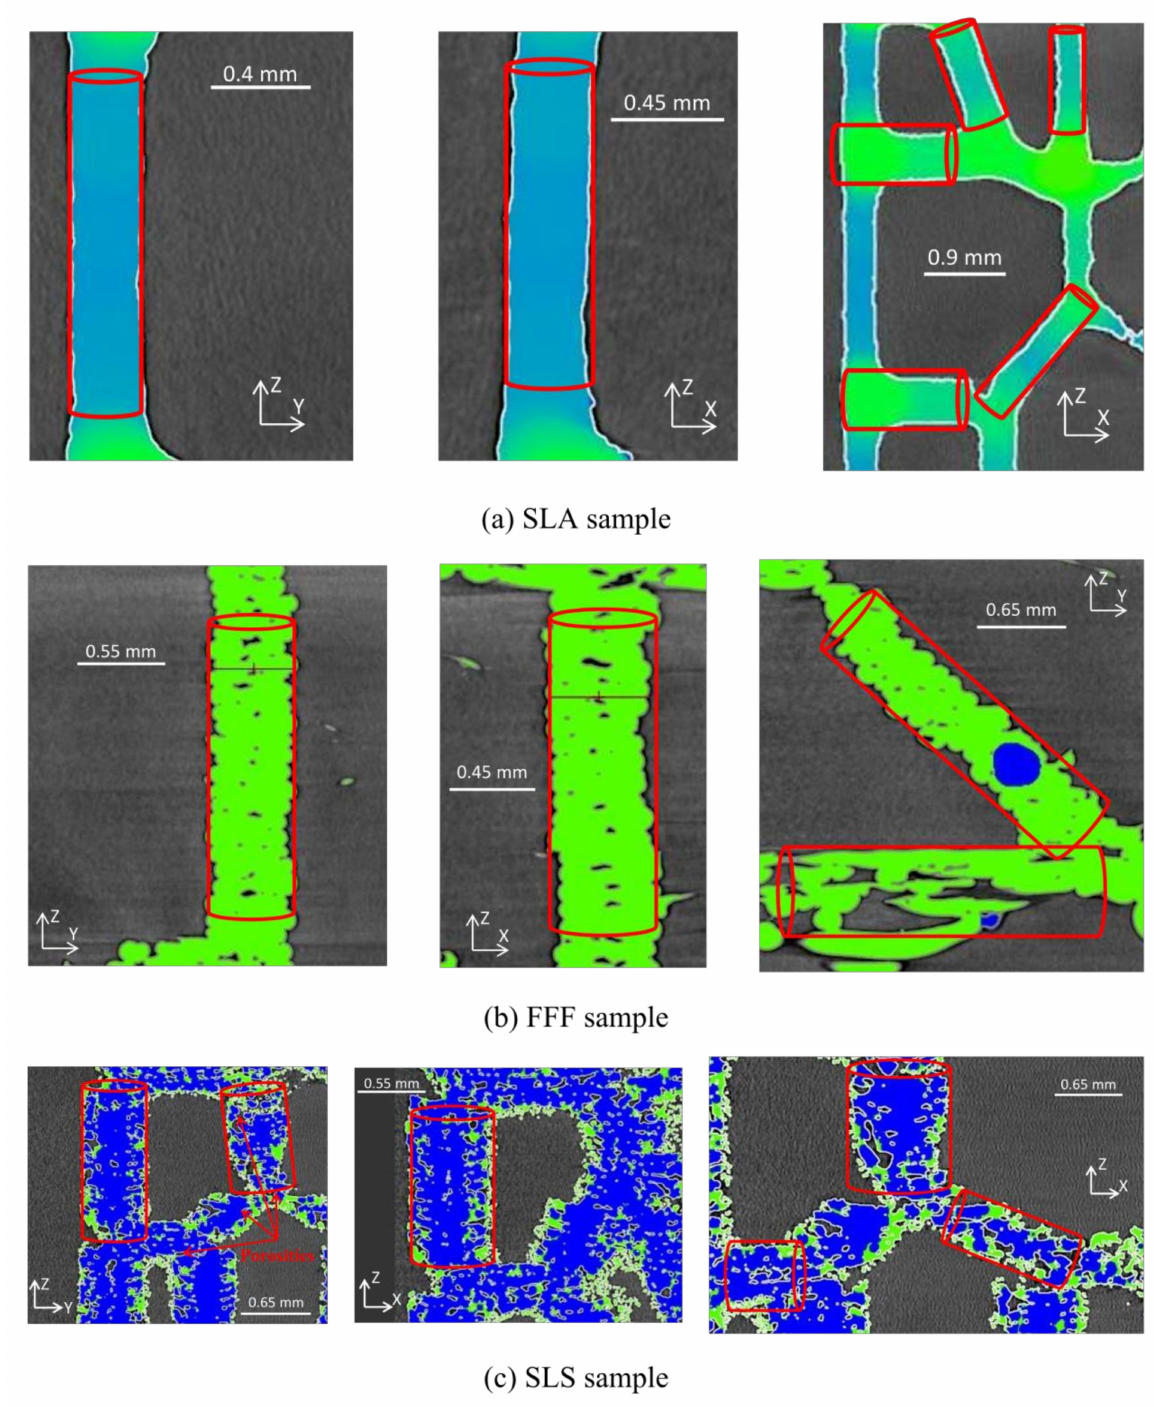
Figure 7. Strut cylindricity of sample 05 for the three processes. These observations and eccentricity measurements were made on one specific sec- tion of each structure. Therefore, their reproducibility is difficult to evaluate because it would require investigating all struts on their whole length. Therefore, to complete the tomographic observations, an evolution of the variation of the section of the struts of the printed architected structures was performed through statistical dimensional analysis. This approach consists of exporting the cross-sections of the struts contained in slices spaced at 0.1 mm along the three directions X, Y and Z (Figure